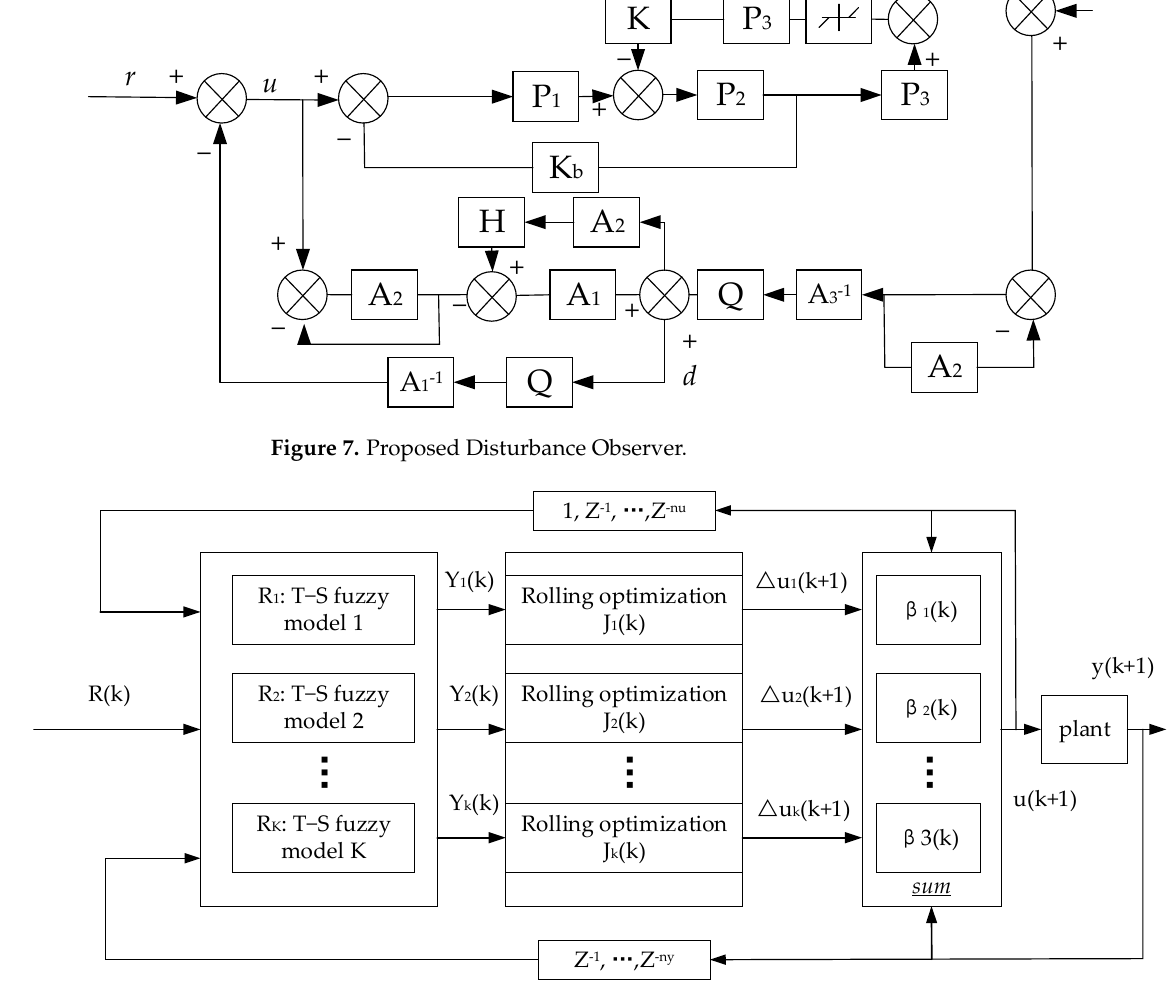
Figure 8. The overall block diagram of the fuzzy predictive control algorithm.